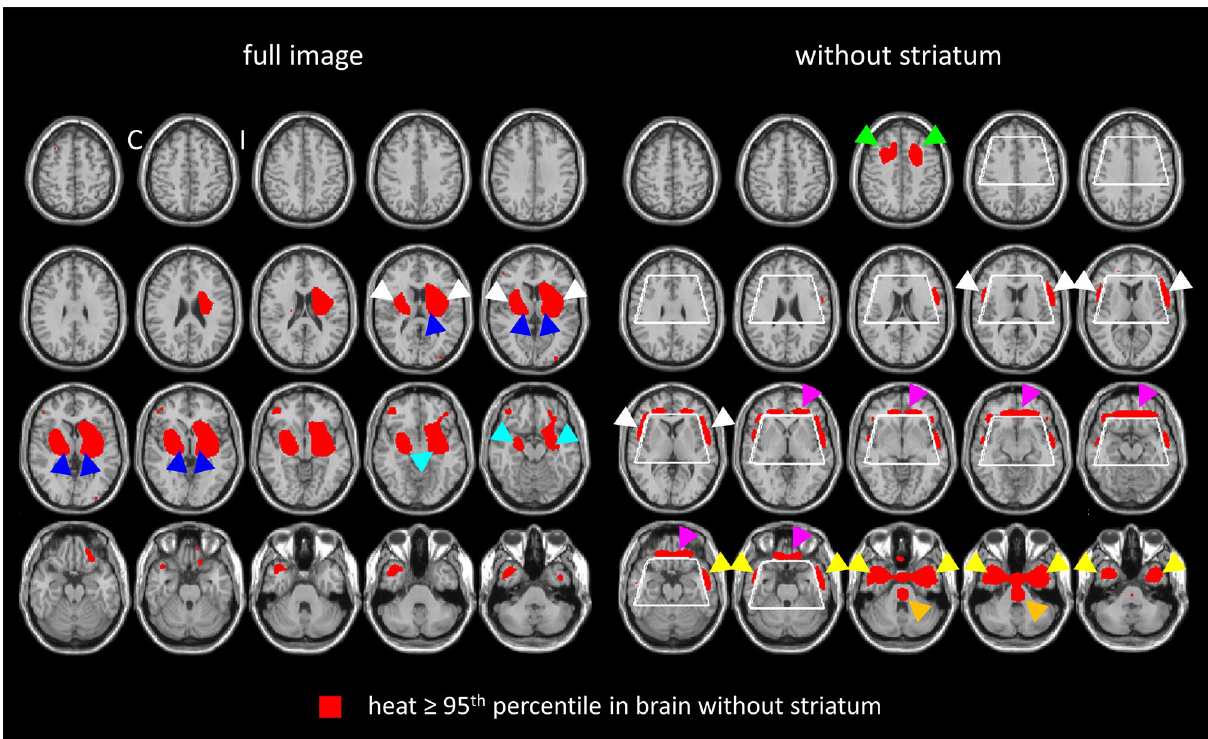
Figure 3. Mean heat maps throughout the whole brain. Mean heat map of the correctly classified 123 I-FP-CIT SPECT images in the “full image” setting (left) and in the “without striatum” setting (right) overlaid to the single subject T1w-MRI template of SPM12. The mean heat maps were thresholded at the 95th percentile of the heat values in the brain except the striatum region (white contour), separately in both settings. The arrow heads point to the clusters of increased relevance in the insula region (white), the amygdala (aquamarine), the ventromedial prefrontal cortex (purple), the thalamus (blue), the anterior temporal cortex/temporal pole (yellow), the superior frontal lobe (green) and in the pons (orange) ( C contralateral, I